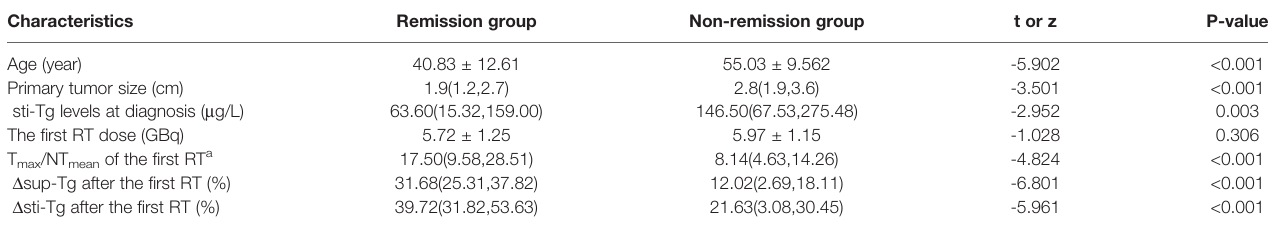
TABLE 2 | Univariate analyses for the continuous variables.